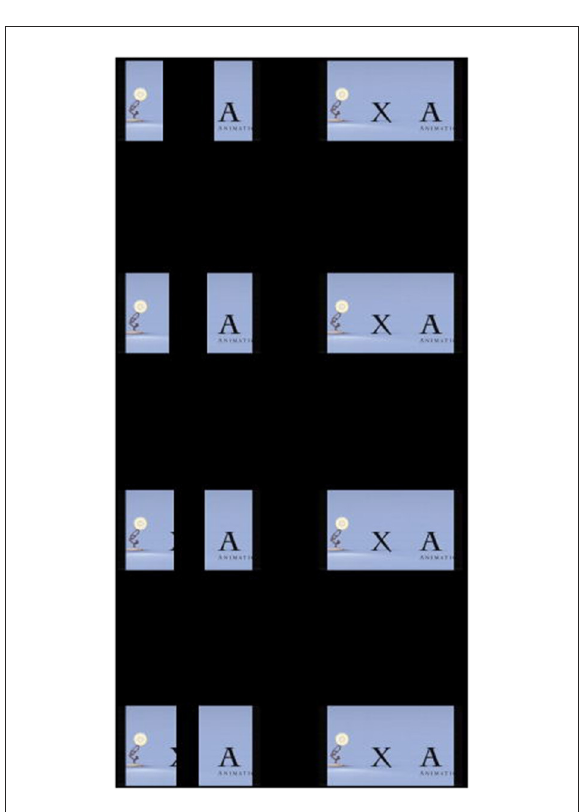
the visual training and stimulation of the central vision of the amblyopia eye (Figure